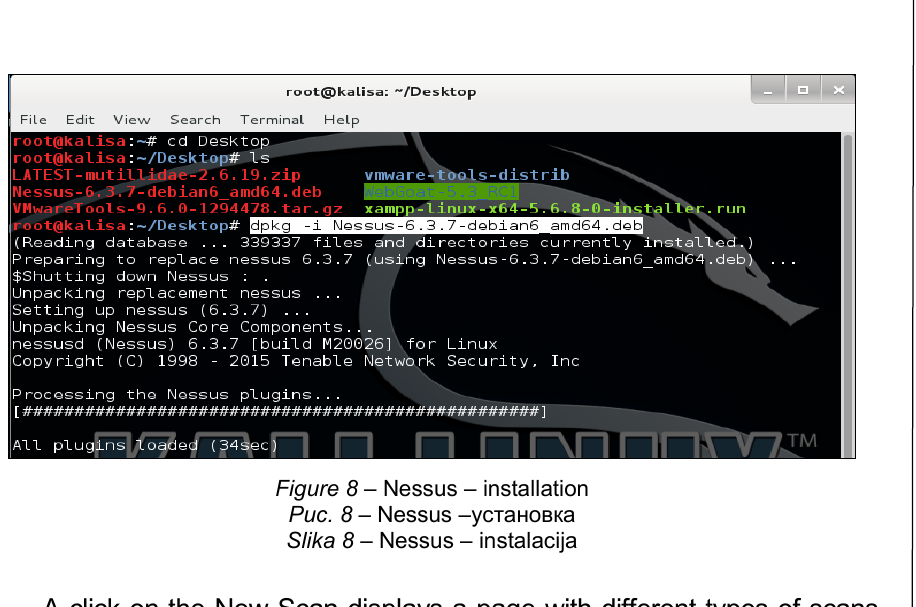
Figure 8 – Nessus – installation Рис . 8 – Nessus – установка Slika 8 – Nessus – instalacija